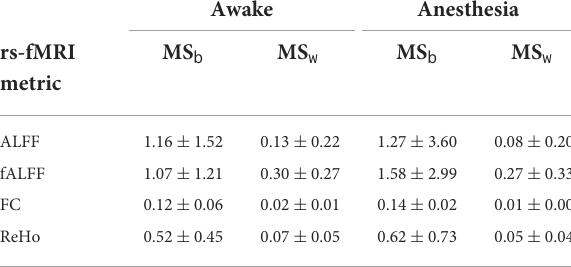
TABLE 2 Mean ± SD of MS b (between-subject mean square) and MS w (within-subject mean square) of rs-fMRI metrics including the amplitude of low-frequency fluctuation (ALFF), fractional amplitude of low-frequency fluctuation (fALFF), functional connectivity (FC), and regional homogeneity (ReHo) in two states of awake and under anesthesia.